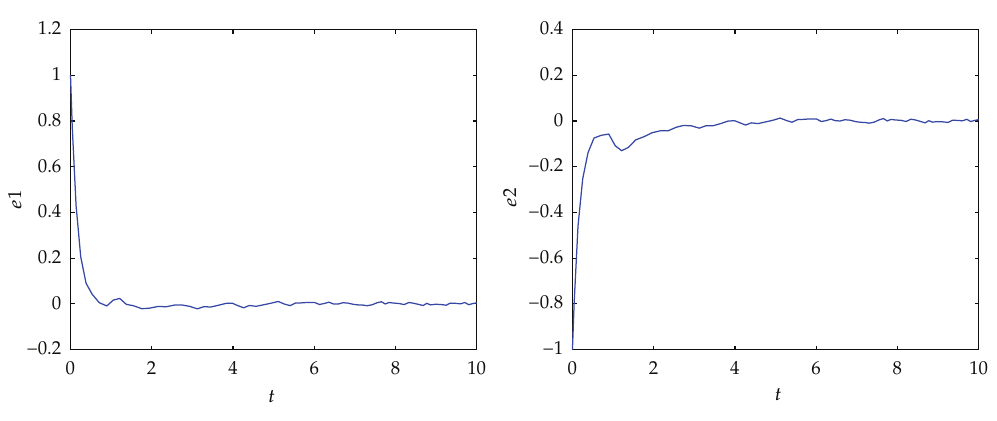
Figure 1: The state trajectories e 1 and e 2 of the network with initial value (cid:2) ϕ 1 (cid:2) t (cid:3) ,ϕ 2 (cid:2) t (cid:3)(cid:3) T (cid:8) (cid:2)(cid:2) tan2 t (cid:3) 2 − 0 . 3 , (cid:2) sin2 t (cid:3) 2 − 0 . 6 (cid:3) T , t ∈ (cid:5) − 1 , 0 (cid:6)